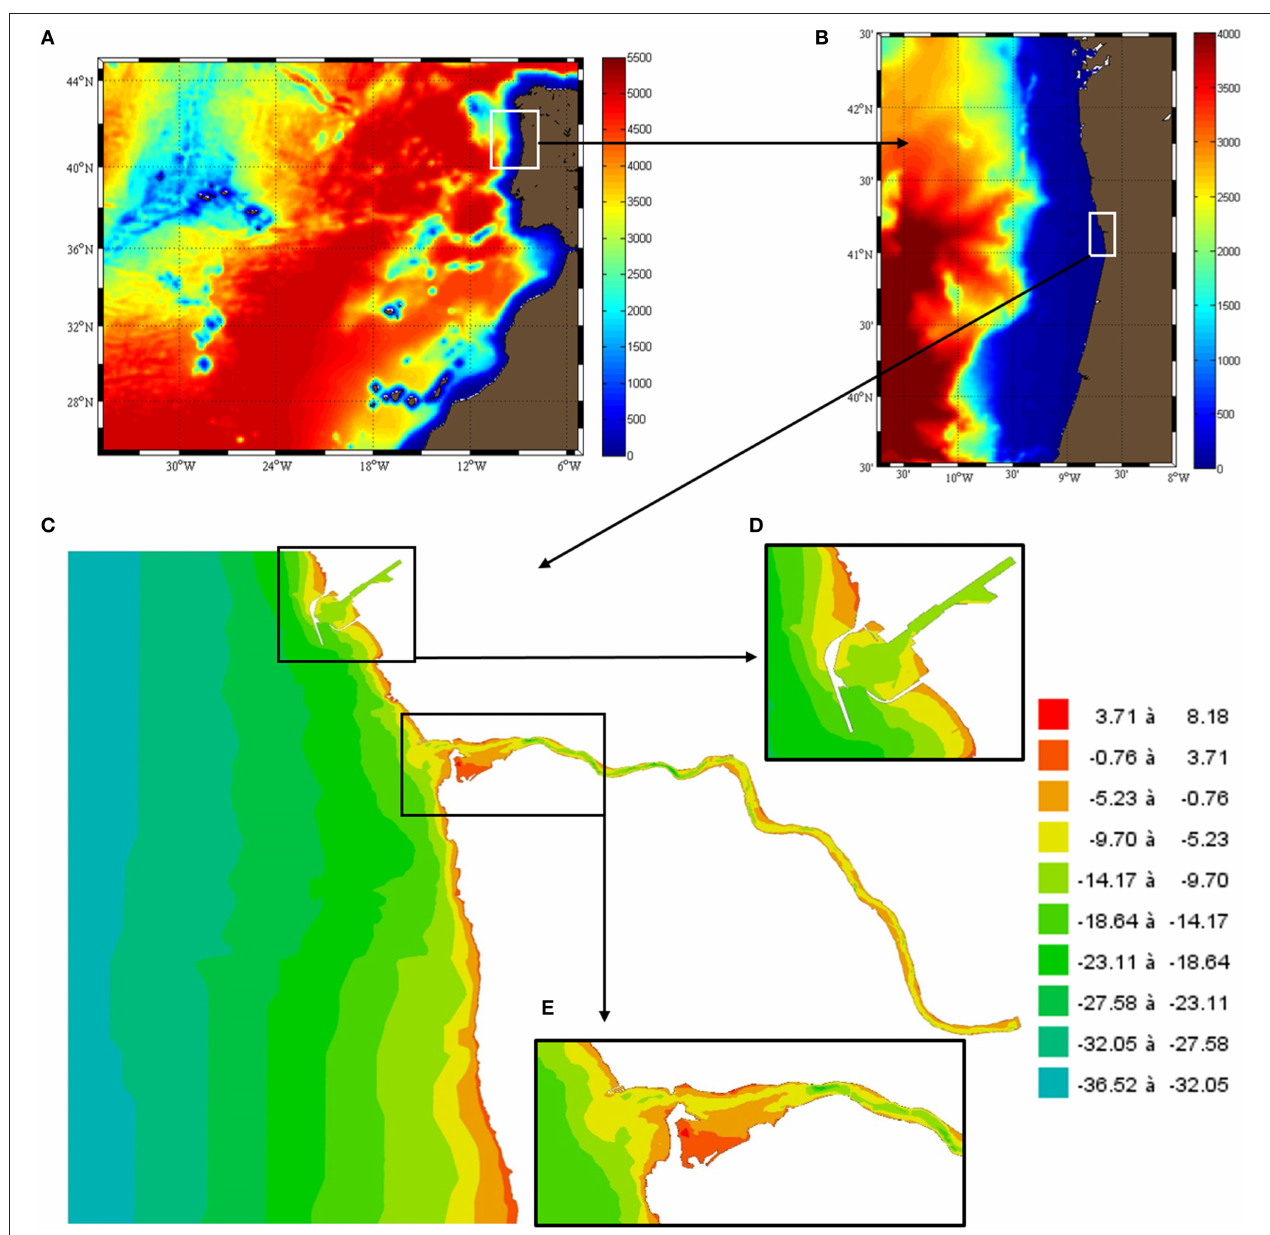
FIGURE 4 | From regional to local modeling. (A,B) Regional domains (ROMS model) (Sala et al., 2013; Iglesias et al., 2014); (C) Local domains for higher resolution modeling (Douro coastal and estuary region) (Iglesias et al., 2016) with zoom performed for (D) Leixões Port, and (E) Douro River mouth. Colors represent the bathymetry (in meters) extracted from GEBCO (http://www.gebco.net/; subfigures A,B) and provided by the IH (subfigure C).